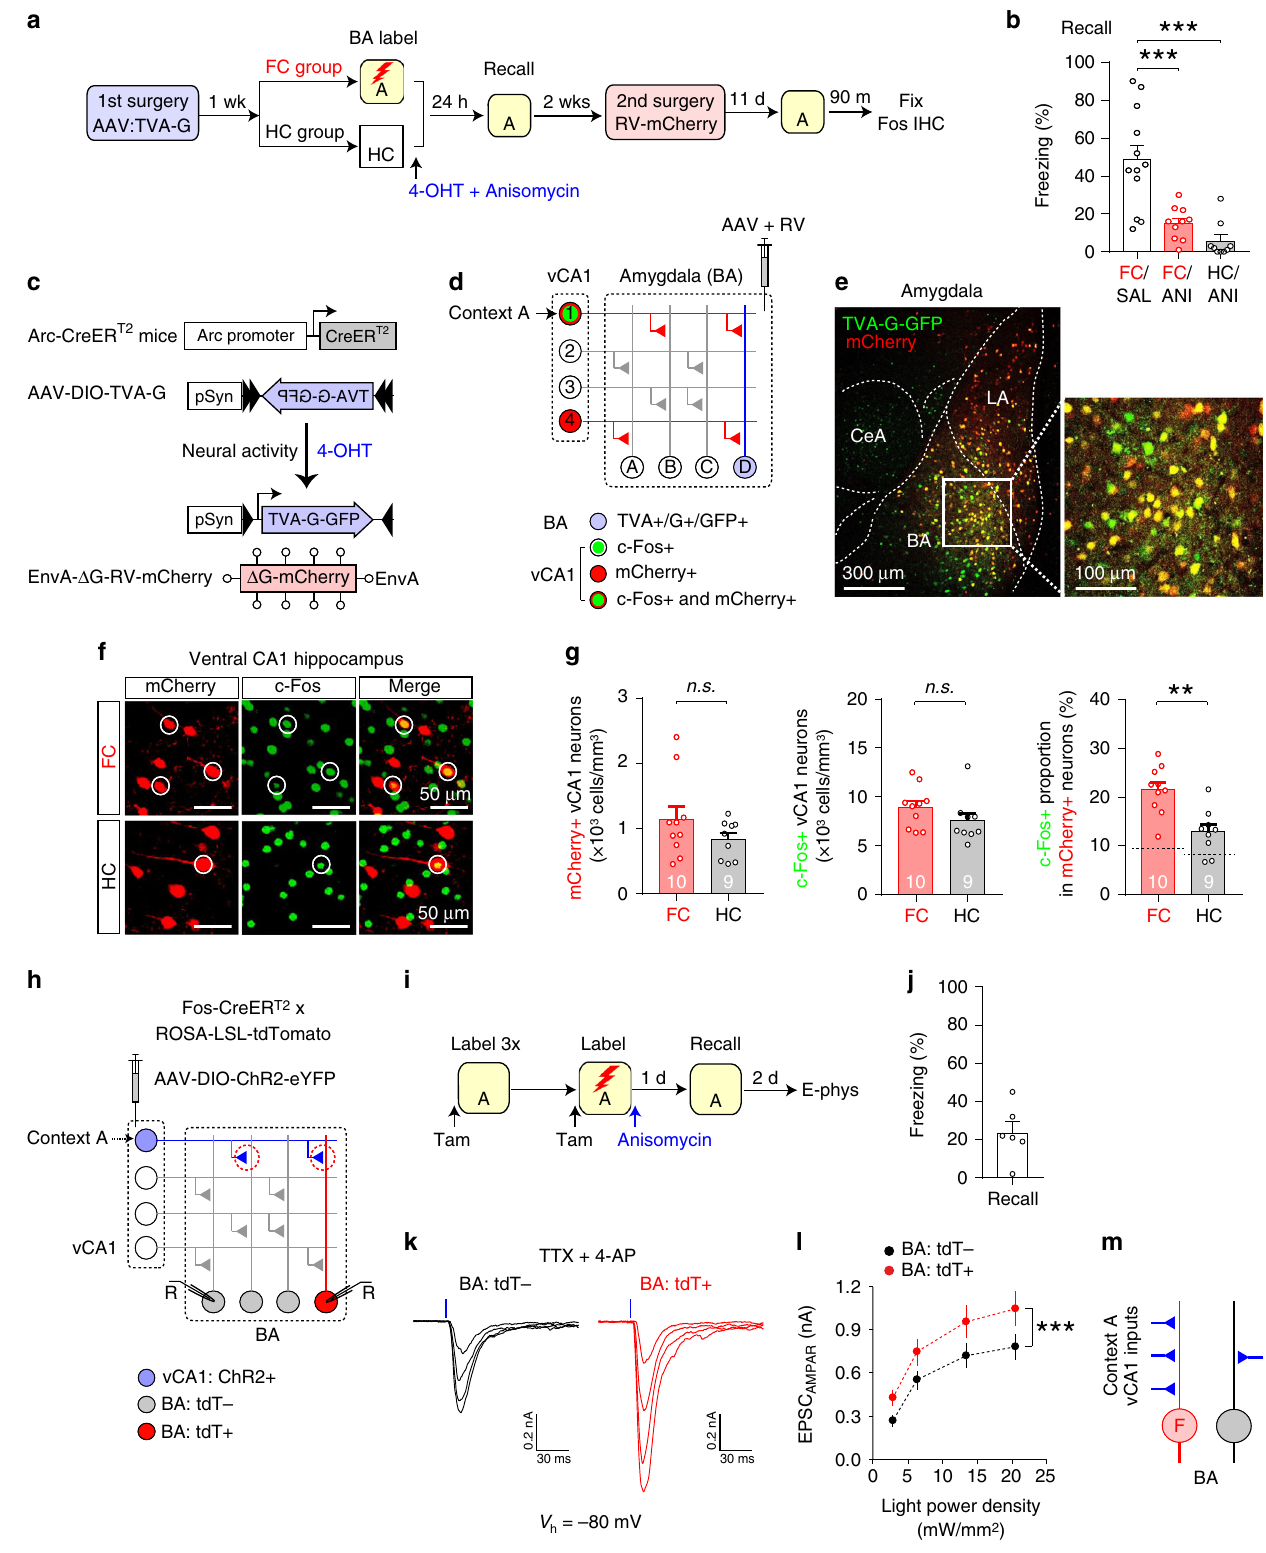
with our approaches represents neurons active during context exposure or contextual fear conditioning. Contextual fear learning requires coordinated activity in the hippocampus and the amygdala 10,23,32,33 . Contextual repre- sentations encoded in the dorsal CA1 (dCA1) hippocampus are